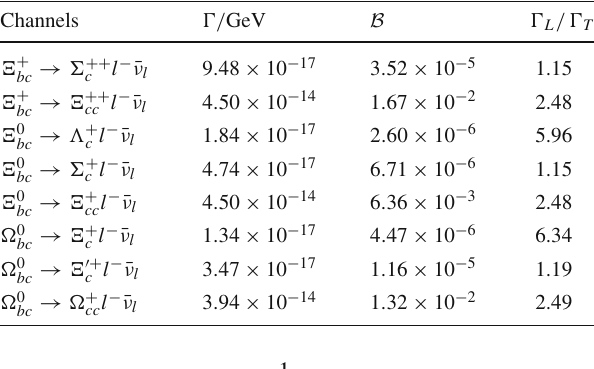
Table 20 The bc sector with the b quark decay and an axial vector bc diquark in the initial state: decay widths, branching ratios and